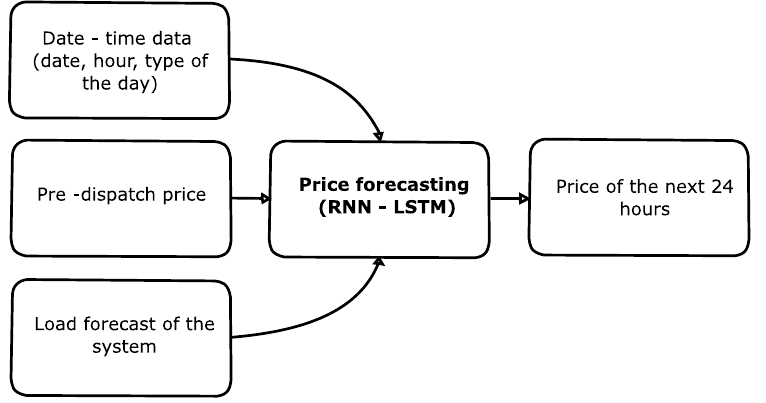
Figure 5. Price forecasting structure.